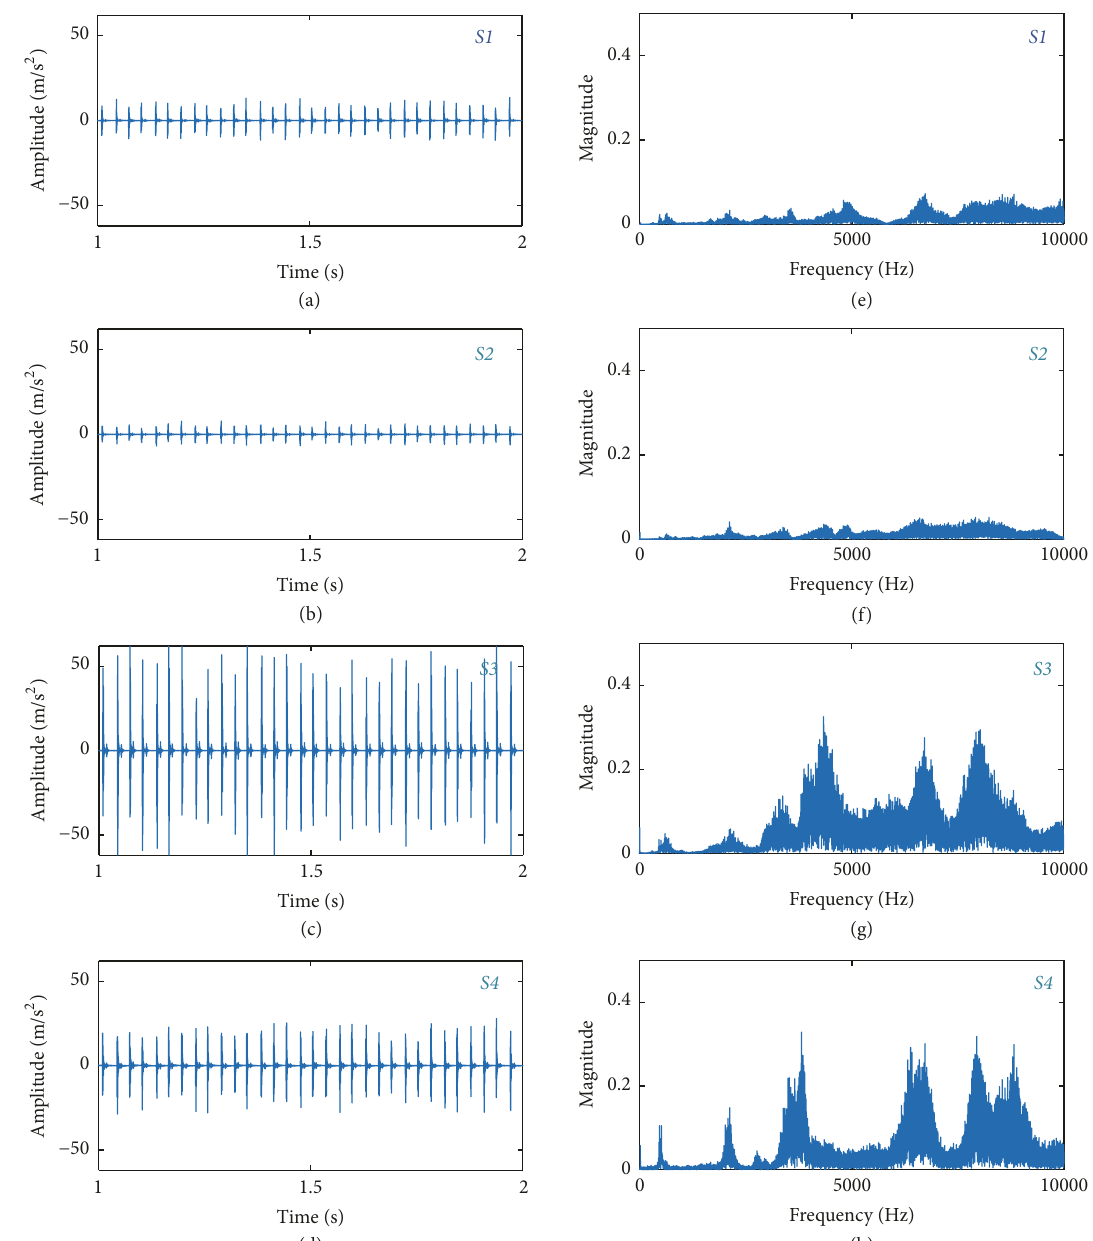
Figure13:Casestudy3:thecapturedtimedomainvibrationsignalsfromS1toS4in(a)to(d),respectively,andtheircorrespondingspectrums in (e) to